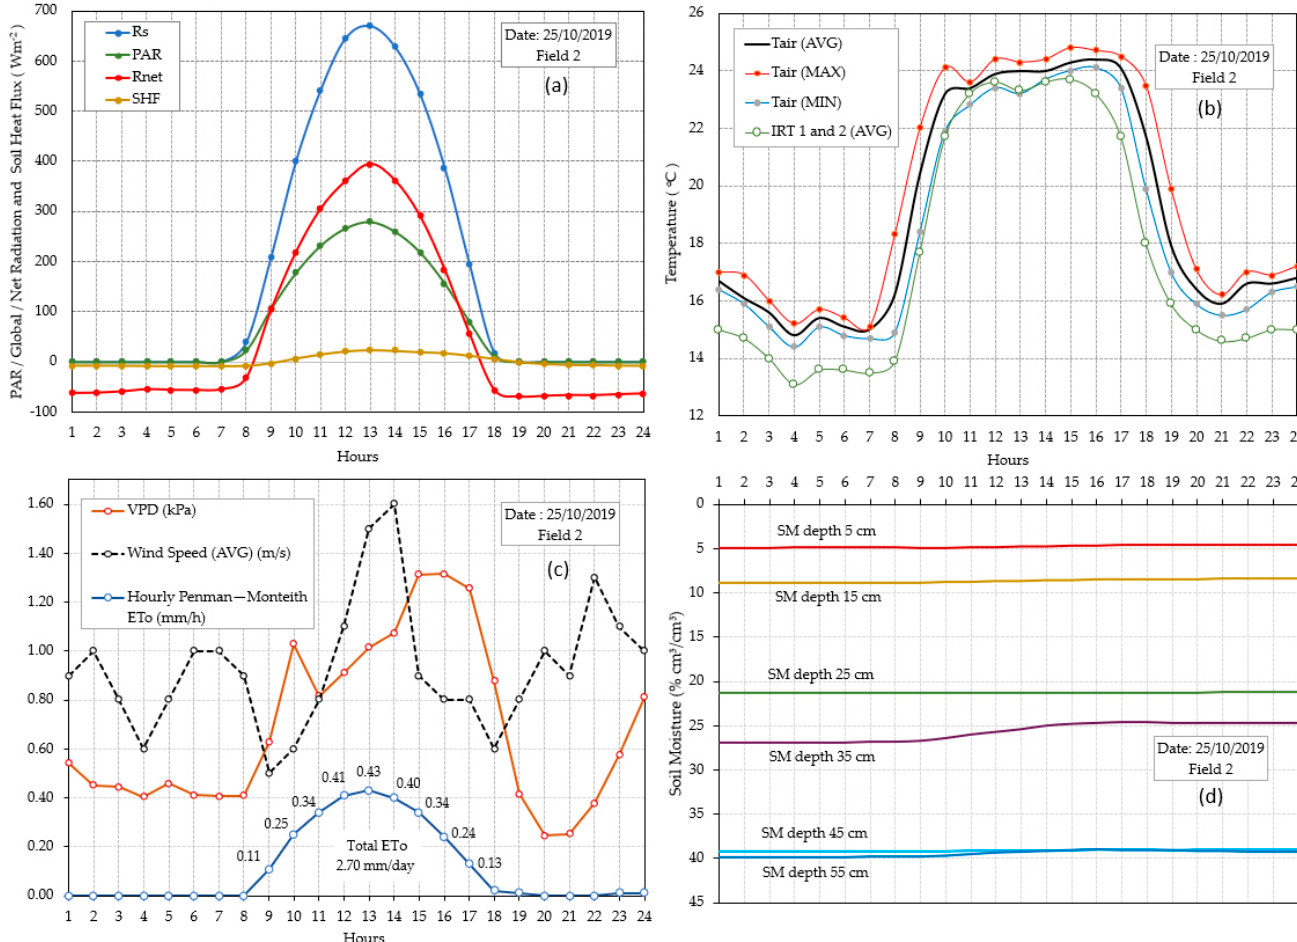
Figure 12. Hourly values for the date 25/10/2019 for the ( a ) global solar radiation Rs, net radiation Rnet, photosynthetically active radiation PAR, and soil heat flux SHF; ( b ) air and canopy temperatures; ( c ) vapor pressure deficit VPD, wind speed WS, crop evapotranspiration; ( d ) soil moisture profile for six depths measured in the potato field.